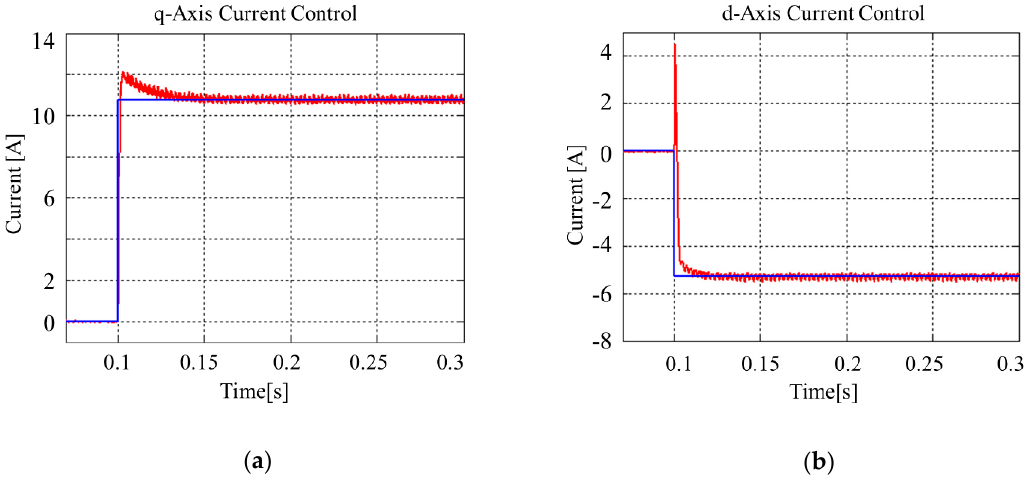
Figure 10. Simulation result of current control output with MTPA: ( a ) q-axis and ( b ) d-axis. Energies 2018 , 11 , x FOR PEER REVIEW